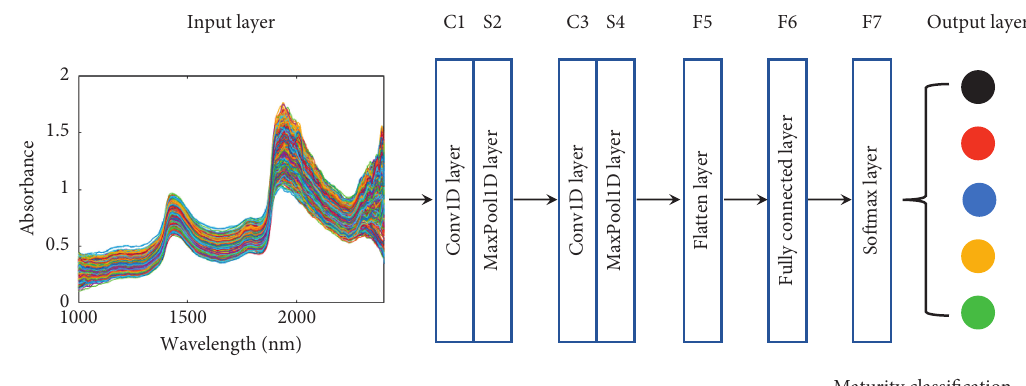
Figure 3: Schematic diagram of convolutional neural network model. Table 4: Parameter settings of the convolutional neural networks for upper, middle, and lower leaves data sets. Layers Model